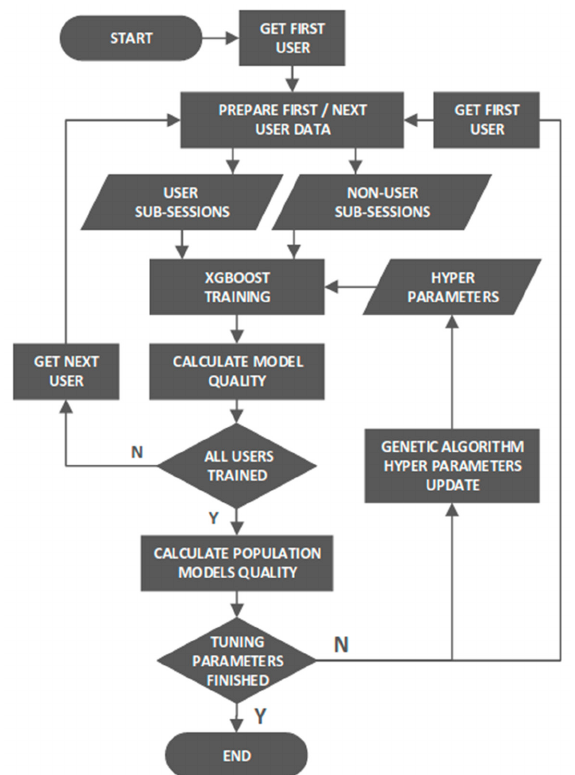
Figure 7. Flow chart representing the XGBoost classifier hyperparameter optimization process.